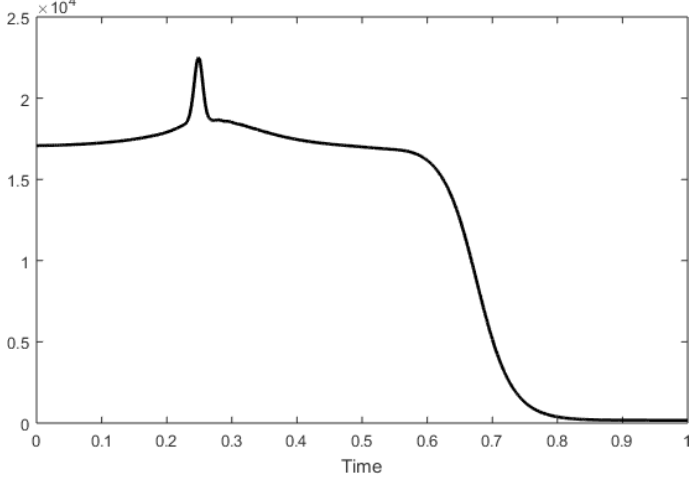
versus time for Z = L 2